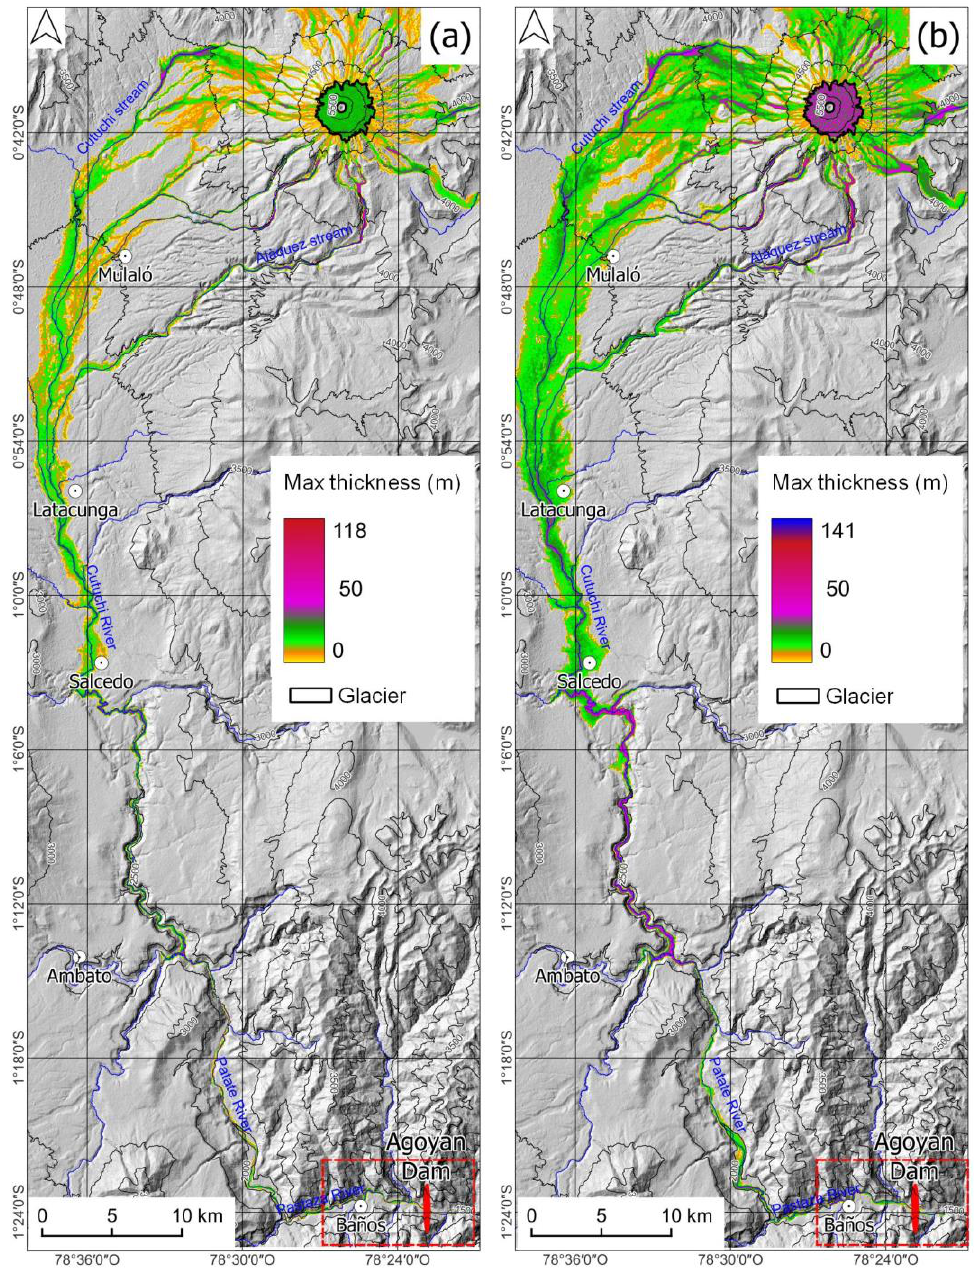
Figure 5. LLUNPIY-PB simulations corresponding to a gradual melting scenario of the 2020 icecap due to pyroclastic bombs. The maximum thickness reached by the lahar in each cell is reported from the minimum (higher than zero, nearly zero) to the maximum value according to the color bar. ( a ) The S25_125 scenario; ( b ) the S50_500 scenario. The Hidroagoyán area, seen within the red dashed outline, is magnified in Figure 6.